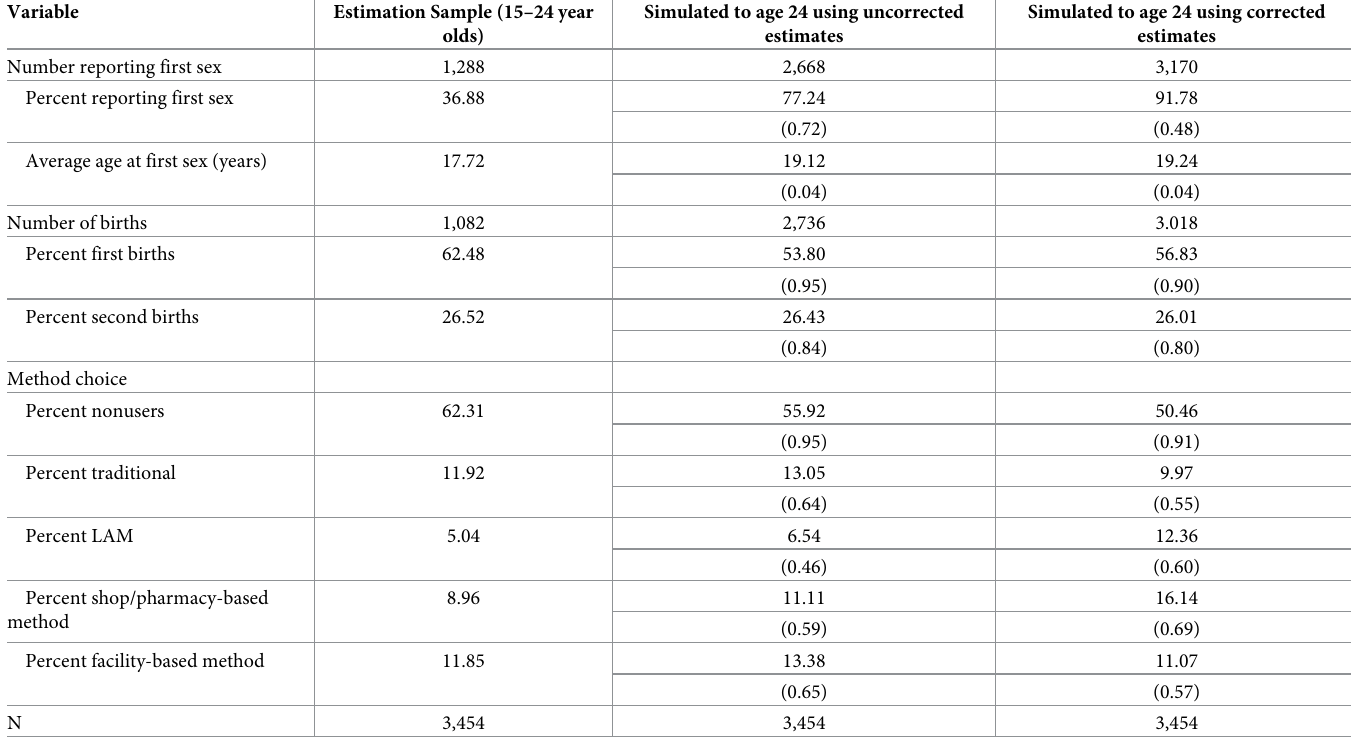
Table 4. Simulation to age 24 for all respondents compared to actual values for the estimation